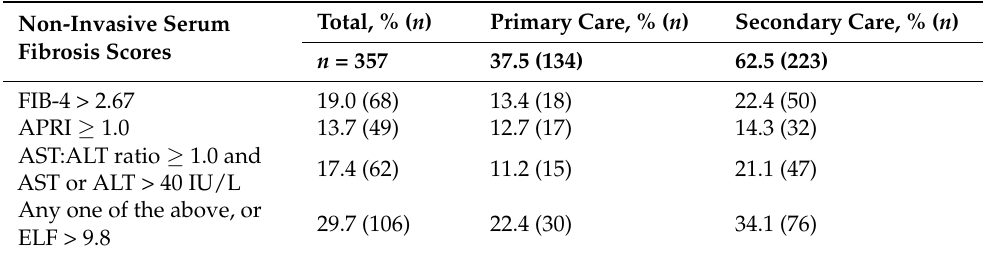
Table 2. Percentage of people with diabetes found to have evidence of significant fibrosis determined by non-invasive